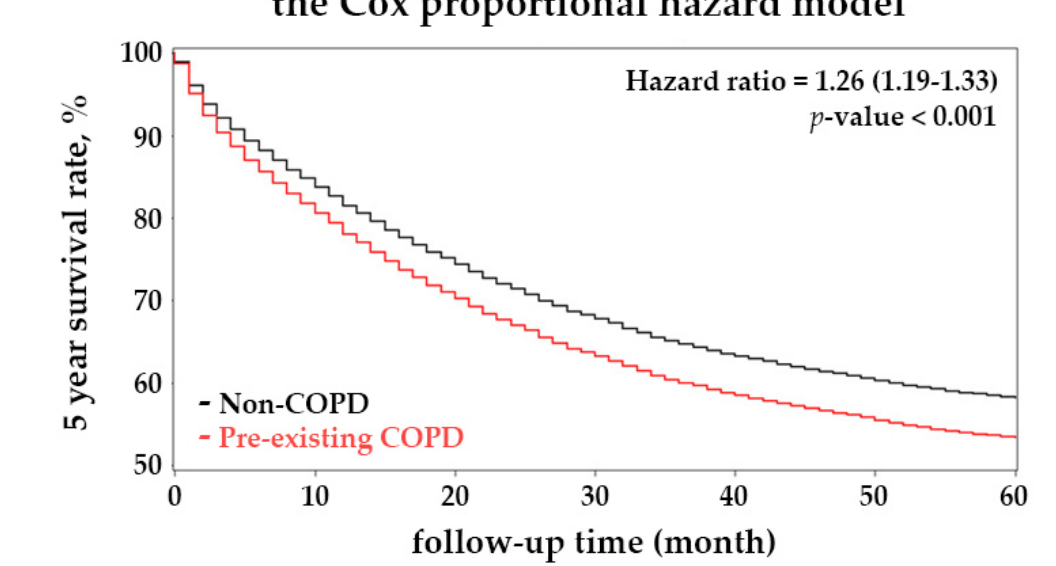
Figure 2. Five-year Cox-adjusted survival curves of patients with colorectal cancer (CRC) and with or without the preexisting chronic obstructive pulmonary disease (COPD) from this matched cohort study. Total 31,896 patients with CRC were matched by comorbidities using PSM with a 2:1 ratio, and the total number is reduced to 13,707 patients. Patients were followed up for 5 years after being diagnosed with CRC. The red line displays the Cox-adjusted survival curve of patients with CRC plus preexisting COPD, and the black line represents the control group. Table 2. Cox regression model with adjusted and non-adjusted hazard ratios and 95% confidence intervals of 5-year overall survival among patients with colorectal cancer in this matched cohort. (Total n =